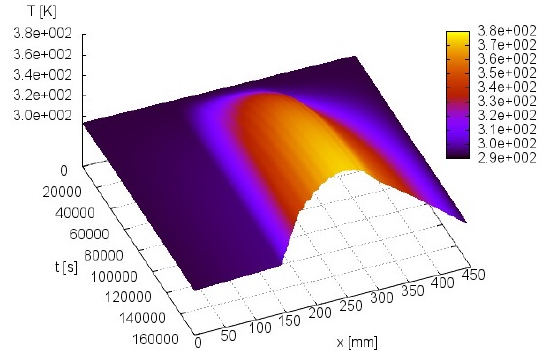
Figure 8. Temperature evolution in Case 2 (temper- ature is stabilized below melting point of fuel material for k eff = 0 . 982